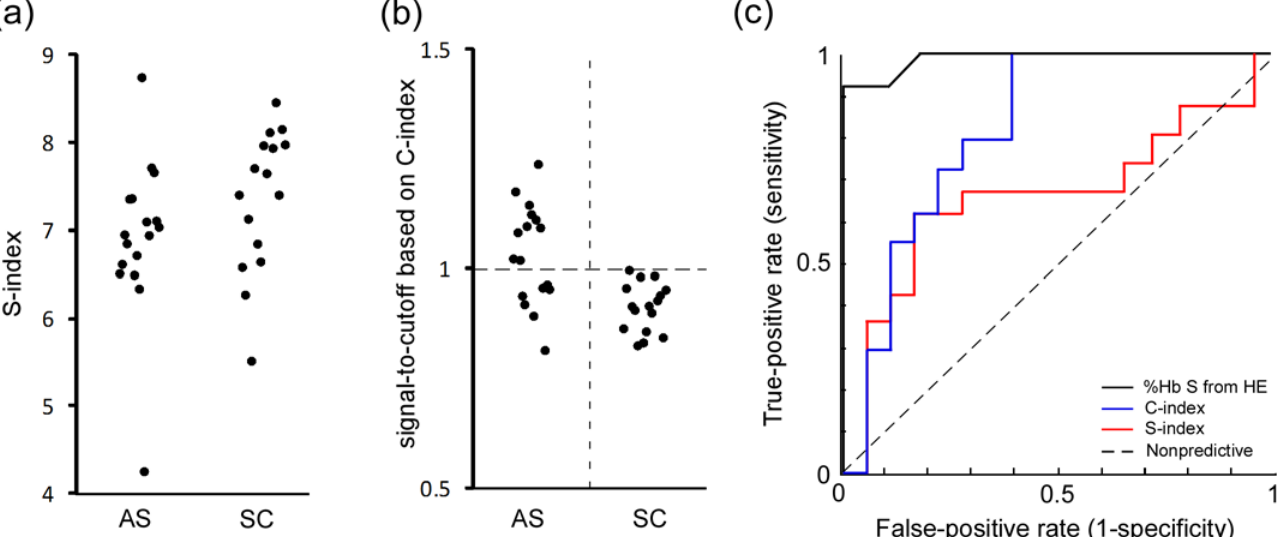
Fig 5. Differentiation of HbSC samples from HbAS samples via automated image analysis. ( a ) The values of S-index for HbAS (n = 17) and HbSC (n = 16) samples. ( b ) Vertical scatter plots of C-index (normalized by cutoff values) for HbAS and HbSC samples. C-index was defined as the product of total color intensity of all pixels in the center area of the blood stain and average color intensity of all pixels at a distance of 5 mm from the center of the blood stain. ( c ) ROC curves for differentiating HbSC and HbAS based on (-) S-index, AUC = 0.67; (-) C-index, AUC = 0.82; and (-) %HbS by electrophoresis, AUC = 0.99.